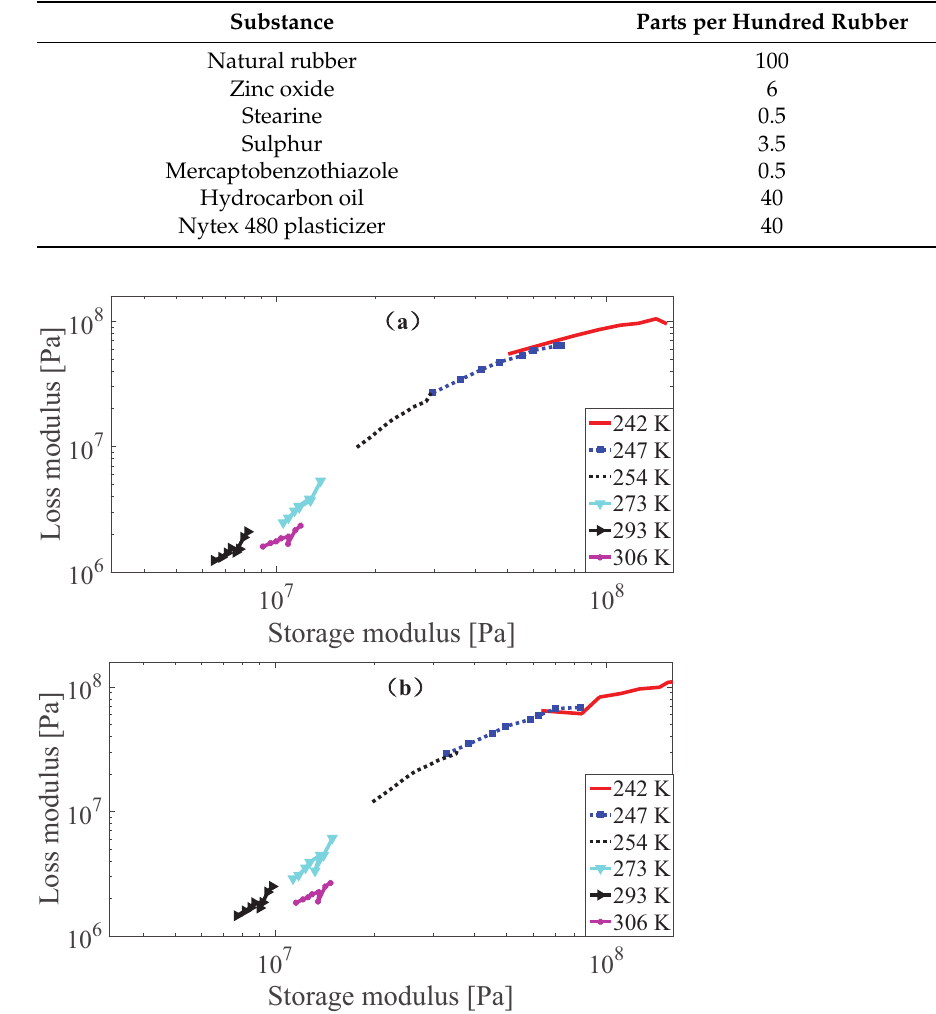
Table 1. Composition of magneto-sensitive (MS) rubber.